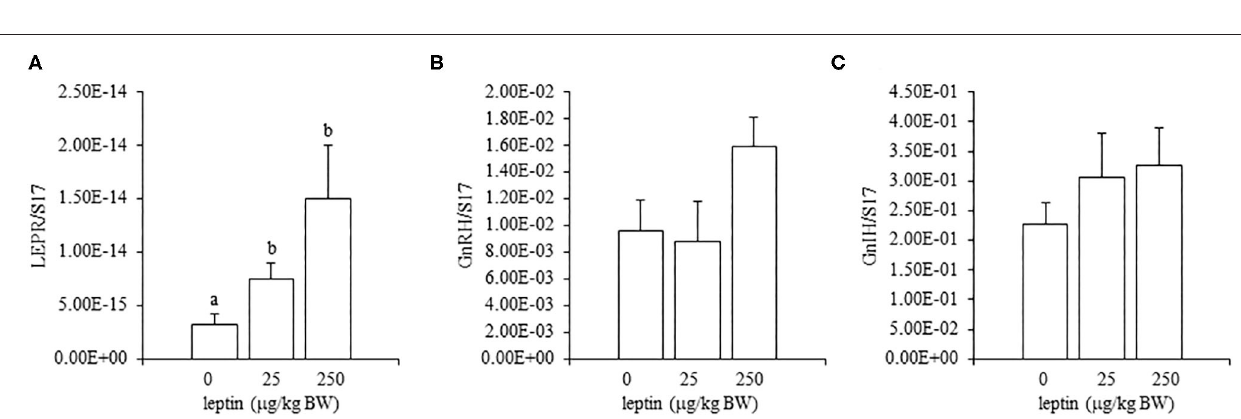
chicks ( P < 0.05). However, in 28-day-old chicks, serum estradiol levels significantly decreased when the highest dose of leptin (250 µ g/kg BW) was administered ( P <